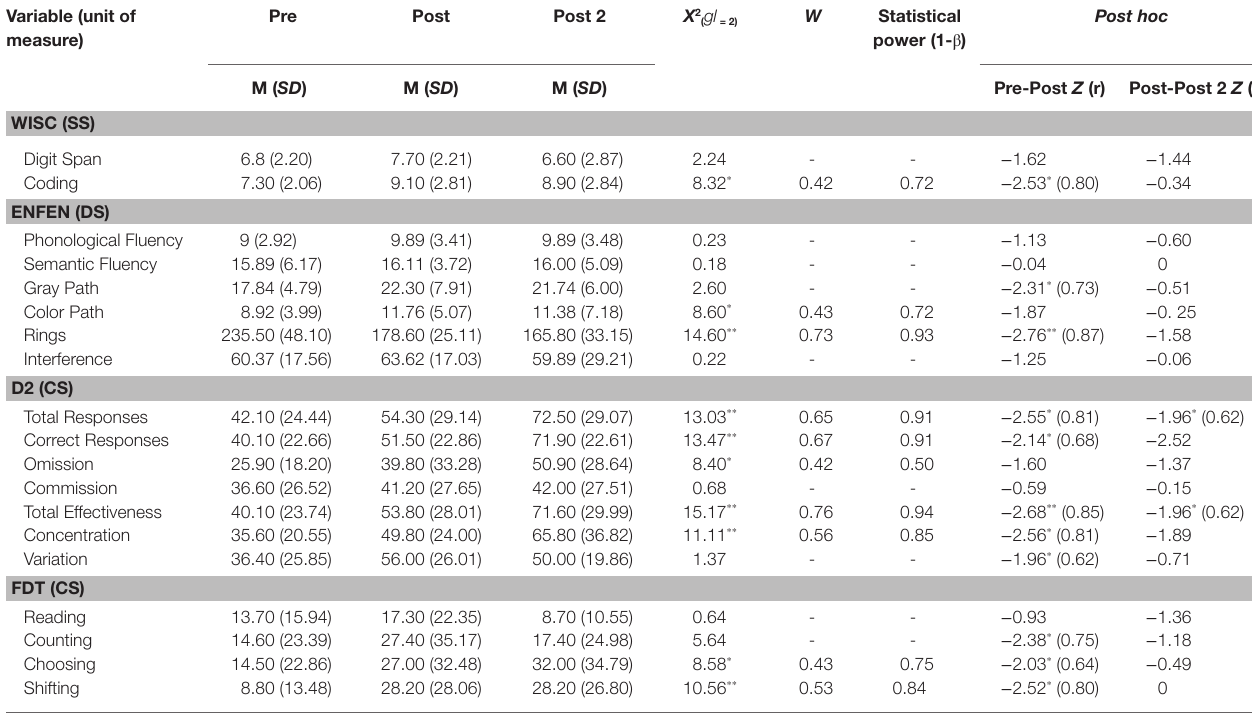
TABLE 3 | Descriptive statistics and non-parametric differences in repeated tasks Pre-Post-Post 2 ( X 2 Friedman), post hoc tests (Wilcoxon Z ), and effect size. Variable (unit of measure)